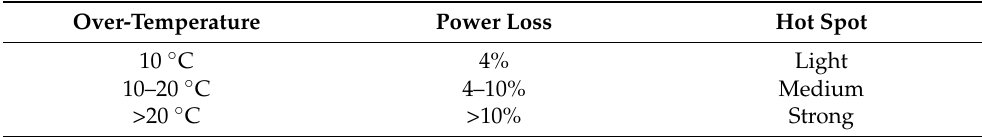
Table 2. Power loss versus over-temperature and classification. Over-Temperature Power